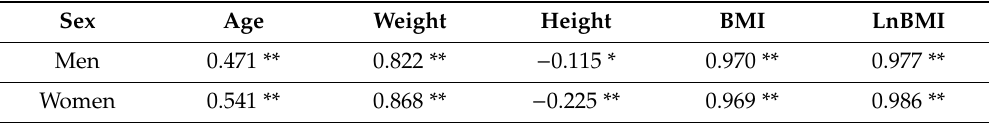
Table 2. Bivariate correlation by sex using CUN-BAE.